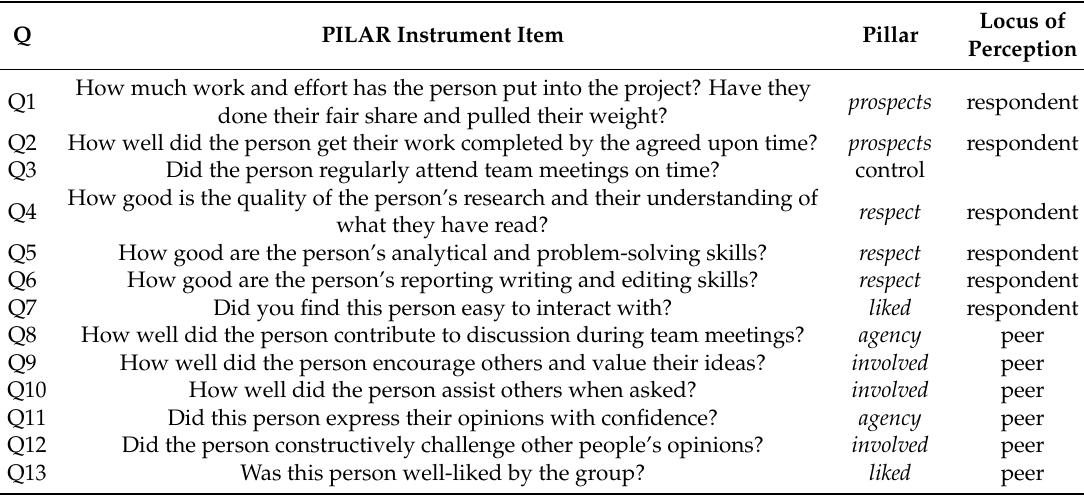
Table 2. Peer assessment questions administered by the online PILAR instrument. For each question, alignment with Pillars, and locus of perception, is